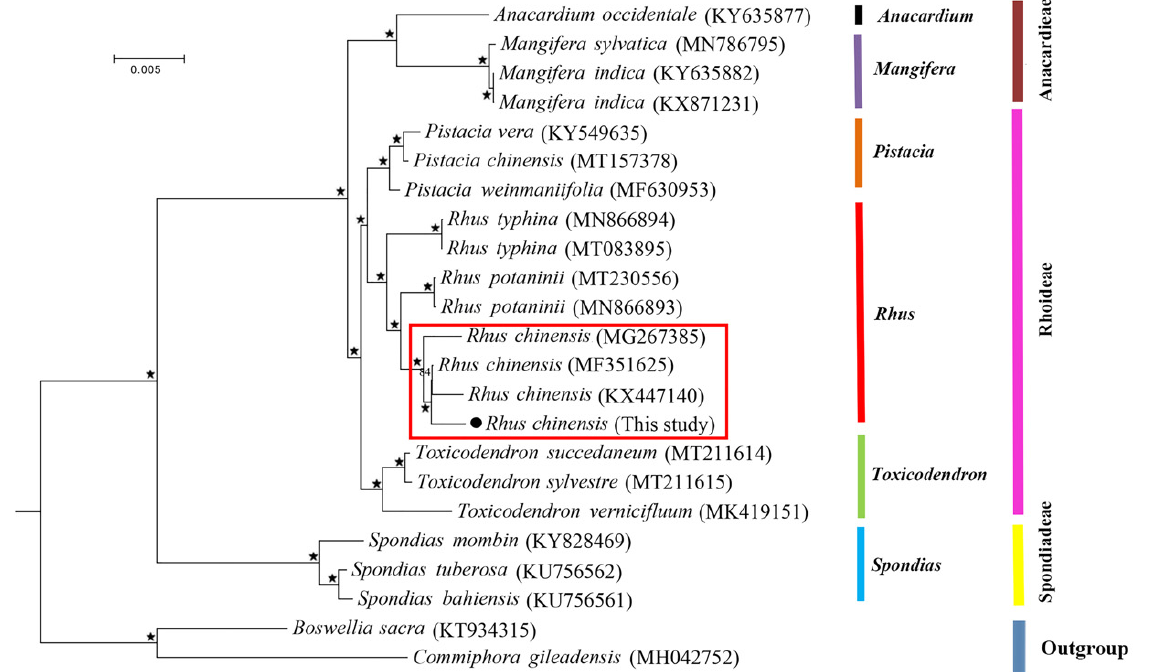
Figure 7. Maximum likelihood (ML) phylogeny of Rhus and other species of Anacardiaceae based on all 86 protein-coding genes with B. sacra and C. gileadensis as outgroups (stars represent nodes with 100% bootstrap values; the clade in the red frame shows the four accessions from the species R. chinensis